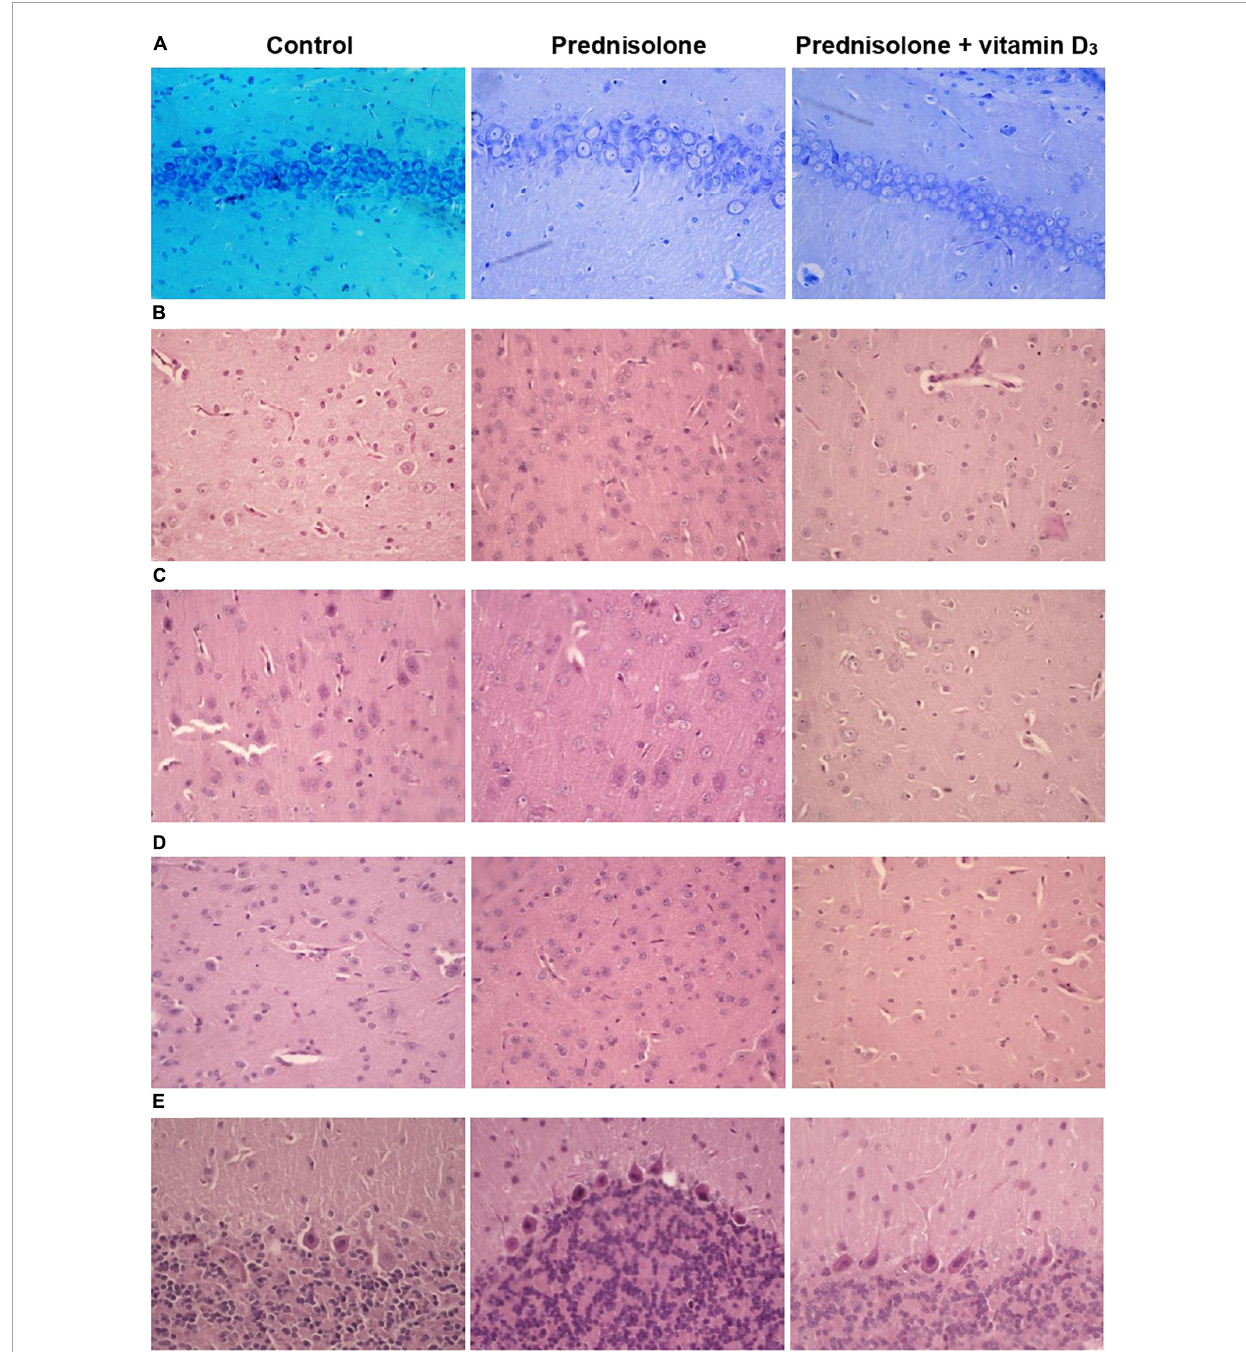
FIGURE5 Histological examination of hippocampus, cerebral cortex, thalamus and cerebellum after prednisolone and vitamin D 3 treatment (toluidine blue or hematoxylin & eosin staining). Representative images of toluidine blue-stained 6- µ m rat CA1 hippocampal sections section (A) , H&E-stained cerebral cortex (prefrontal cortex) (B) , sensory-motor cortex (C) , H&E-stained thalamus sections (posterior thalamic nucleus) (D) , and H&E-stained cerebellar cortex (E) from the control, prednisolone-administered and prednisolone plus vitamin D 3 -administered rats ( n = 5 rats/group, 400 × magnification).